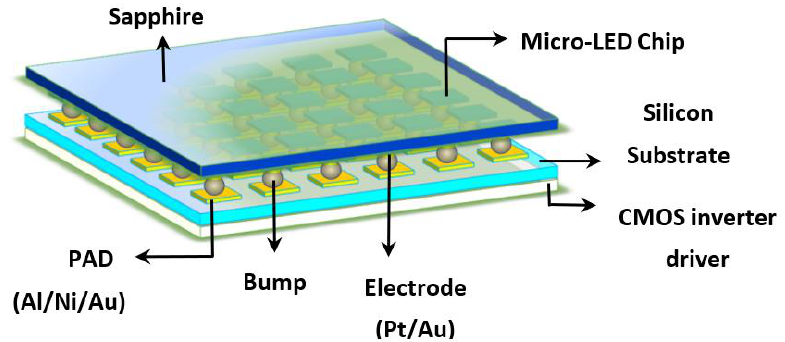
Figure 10. CMOS inverter device driving a micro-LED device, model diagram.